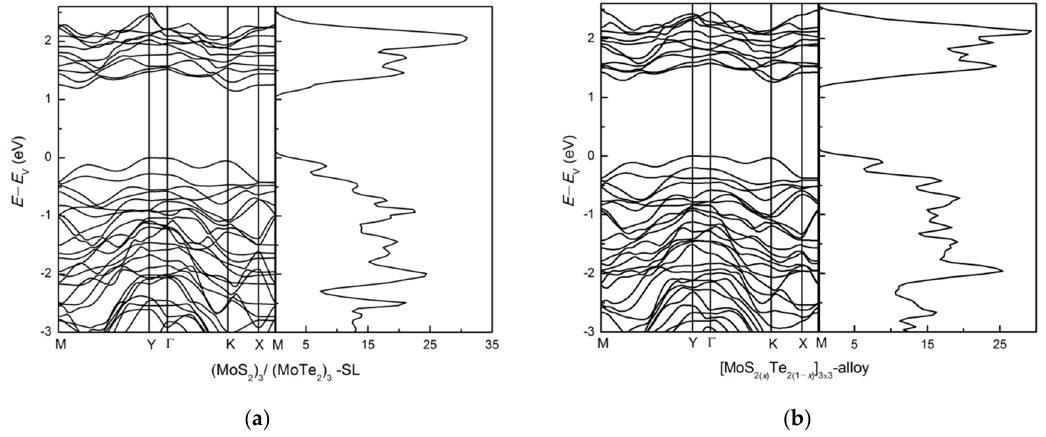
Figure 6. The band structure and dos: ( a ) (MoS 2 ) 3 /(MoTe 2 ) 3 lateral superlattice and ( b ) [MoS 2( x ) Te 2(1 − x ) ] 3x3 alloy superlattice.